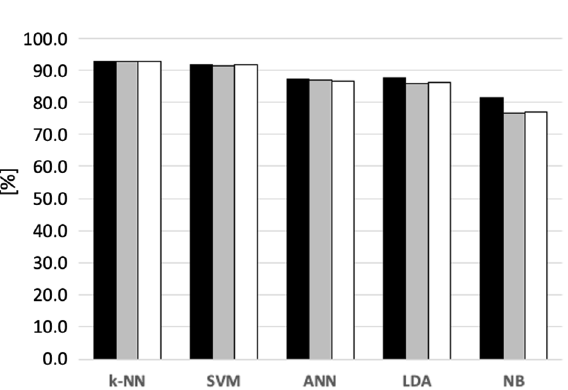
Figure 4. F-Measure test results for the best performance of each classifier: Precision (black) , Recall (gray), and F1-score